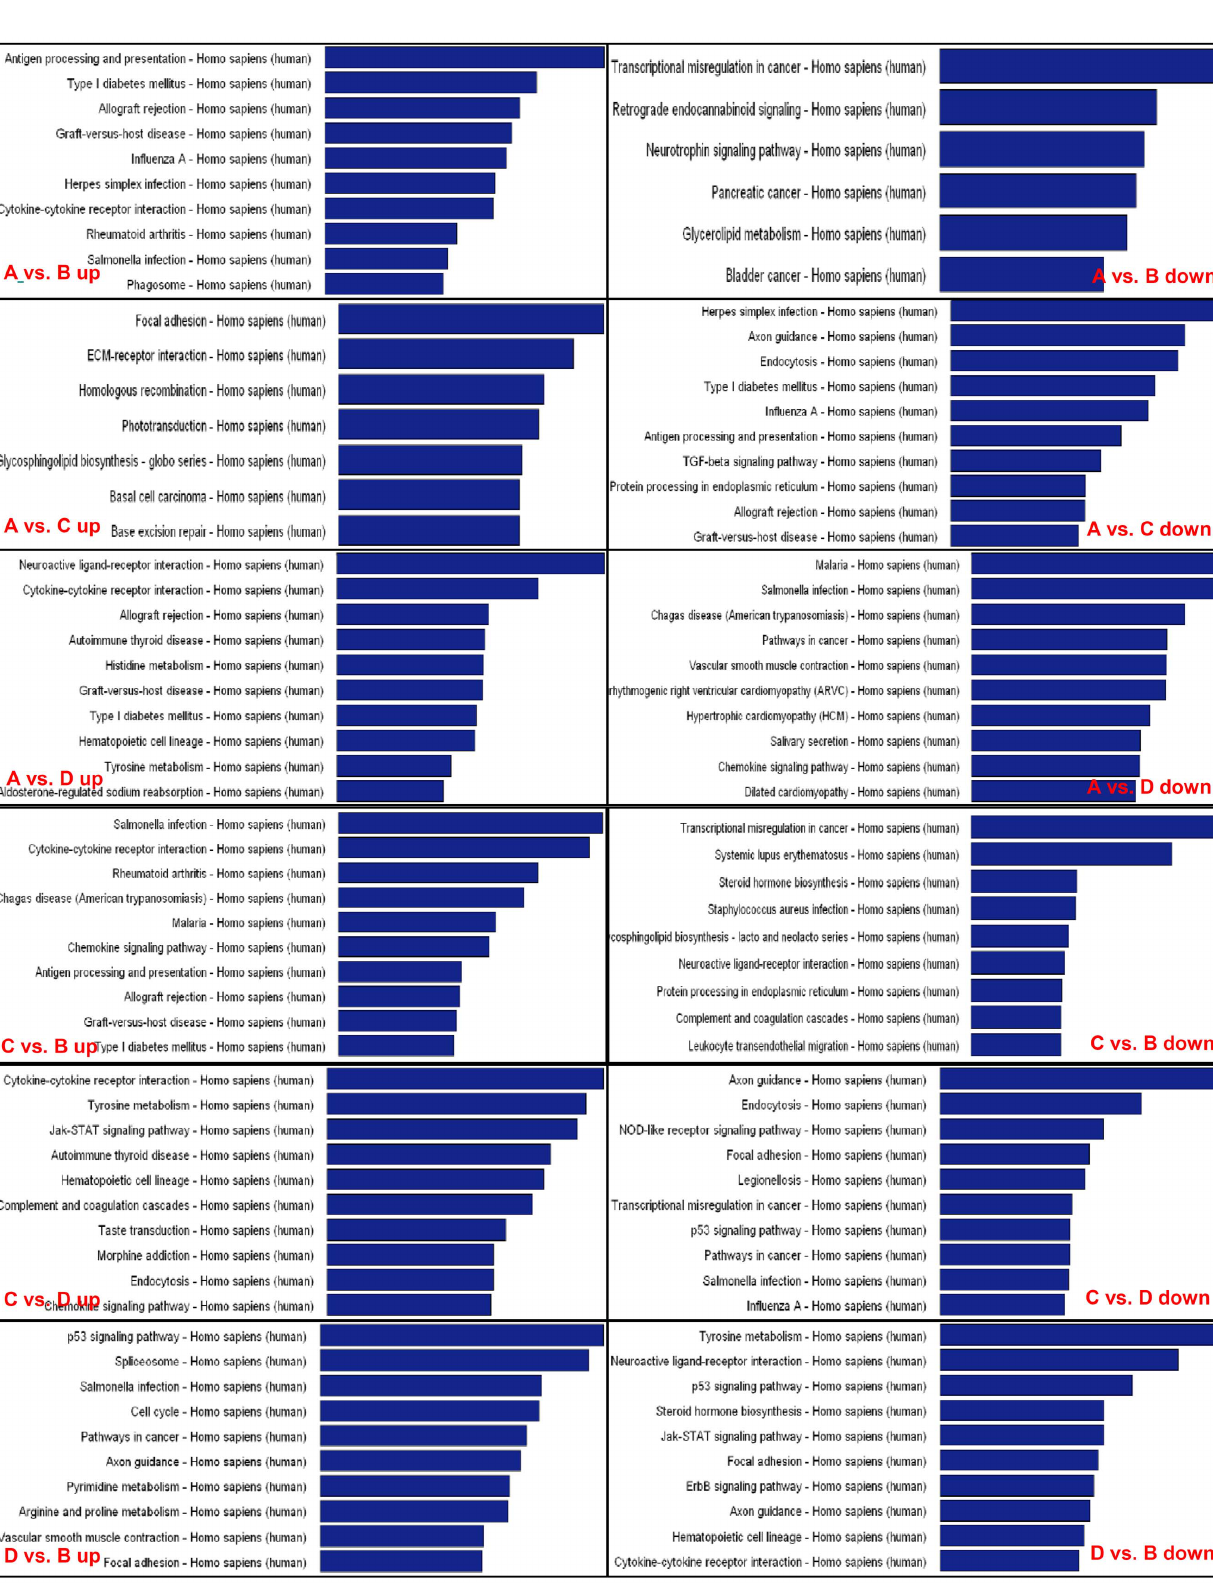
Figure 3. Metabolic pathways characterized from the lncRNAs differentially expressed in PPROM. Six groups of pathways (each group has up- and down-regulated) were characterized with KEGG functional analysis. Three p values, the EASE-score, Fisher-Pvalue and Hypergeometric- Pvalue were integrated for the analysis. The bar plot shows the top Enrichment Score [-log10(Pvalue)] value of the significant enrichment pathway. If there were more than 10 pathways whose Enrichment Score is . 0.05, only the top 10 pathways are shown here. The higher Enrichment Score indicates the more lncRNA molecules are involved in this pathway. doi:10.1371/journal.pone.0079897.g003 PLOS ONE |